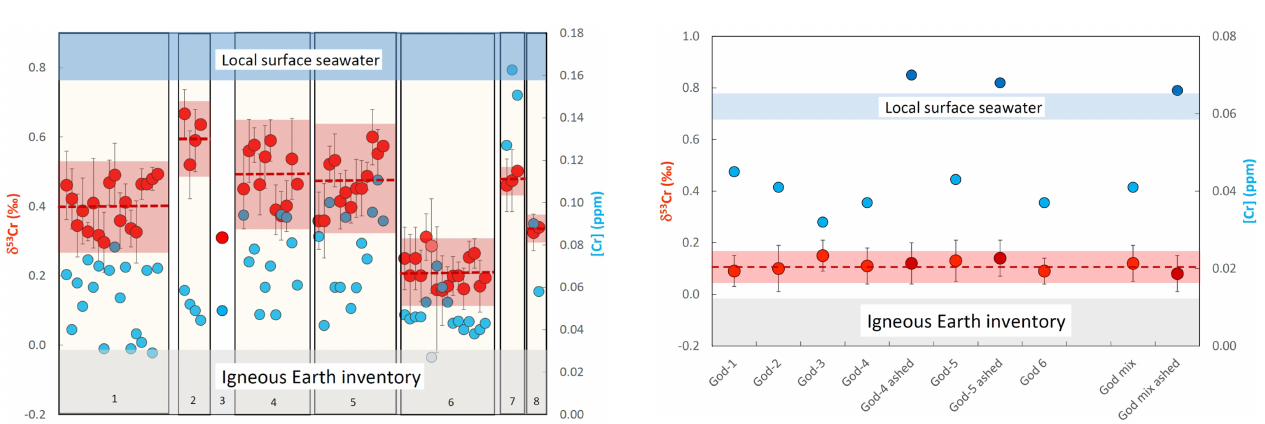
Figure 4. Plot showing the chromium concentrations ([Cr]; blue filled symbols) and chromium isotope compositions ( δ 53 Cr; red filled symbols) of various incinerated bivalve species analyzed from Playa Poniente. (1) Callista Chione ; (2) Cardiidae (species un- known); (3) Chamelea gallina ; (4) Chamelea striatula ; (5) Gly- cymeris glycymeris ; (6) Loripes lucinalis ; (7) Pecten jacobaeus and (8) Venus verrucosa . Dashed red lines mark the average values of inter-species analyses, the red area ranges the two standard devi- ation errors of these analyses. The light gray horizontal bar de- picts the Igneous Earth inventory composition (Schoenberg et al., 2009) and the blue horizontal bar the local surface seawater compo- sition measured from this location. One sample of Loripes lucinalis (marked with a light red and a light blue filled symbol) has been dis- solved in aqua regia without previous incineration. For details see text.